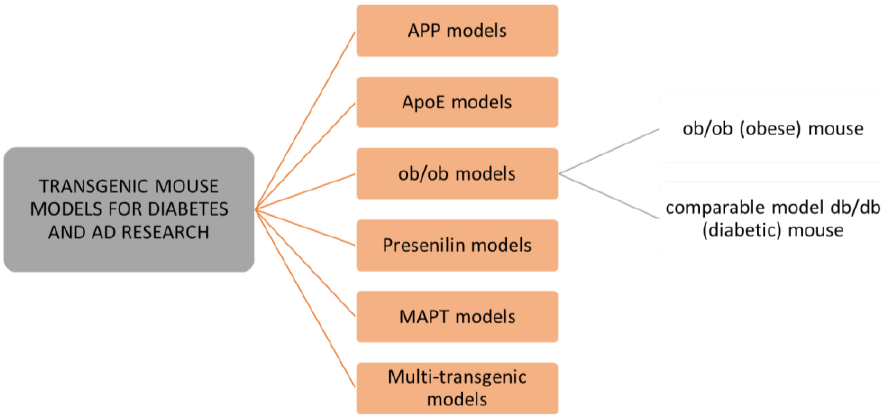
Figure 5. Overview of the most common transgenic mouse models used for studying diabetes and Alzheimer’s